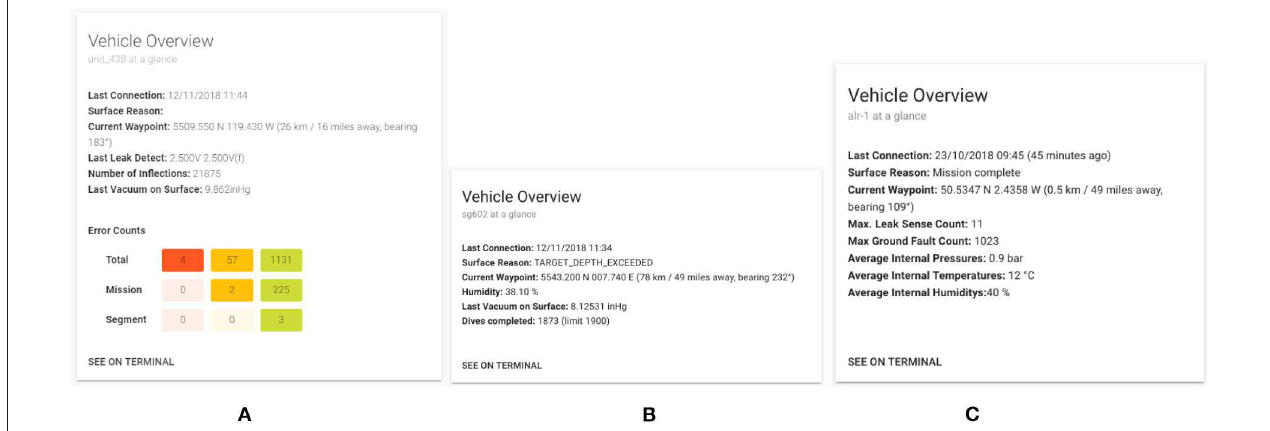
FIGURE 6 | Vehicle overview cards for three different vehicle types, illustrating how the design pattern is maintained despite vehicle differences. The card appears in the same position on the Health page for each vehicle. (A) Slocum glider, (B) Seaglider, and (C) Autosub long